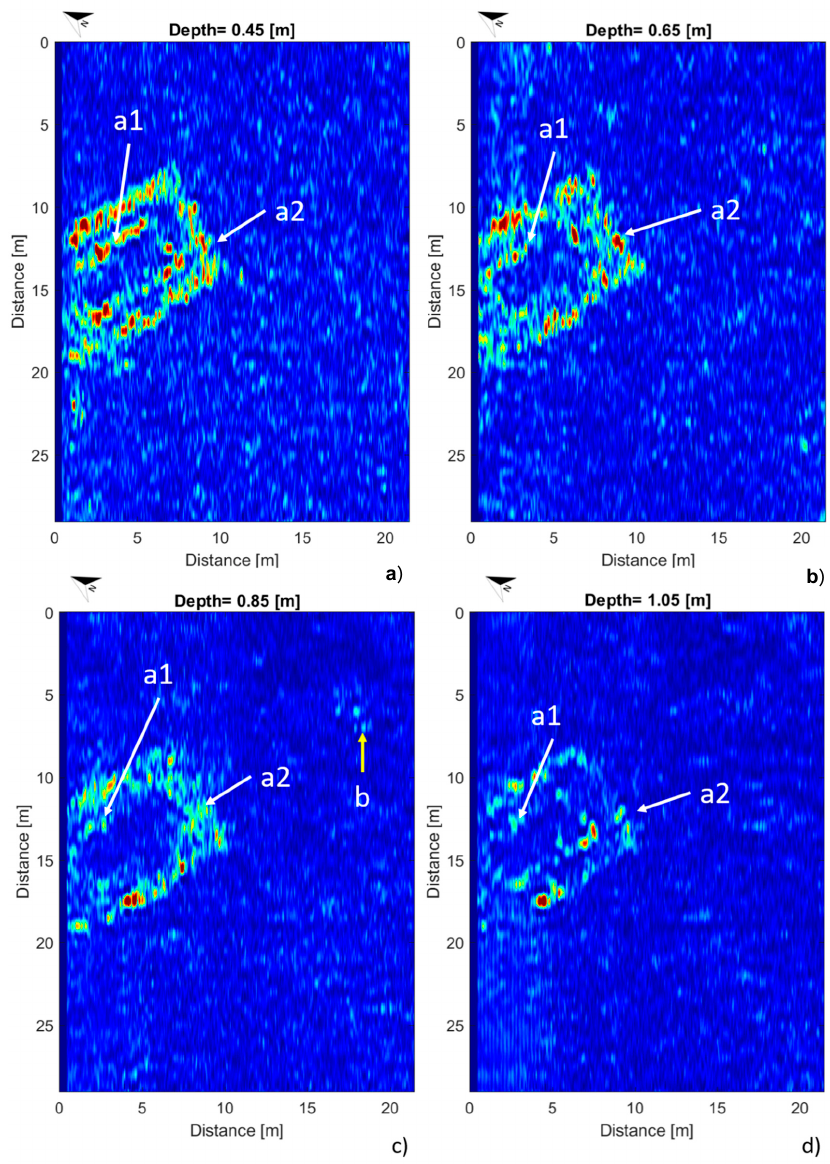
Figure 9. Constant depth slices of the GPR tomographic images at 600 MHz. The main anomalies are indicated by labels and